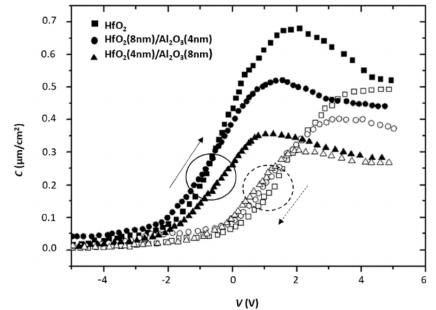
Figure 3. C – V measurements of the MOS